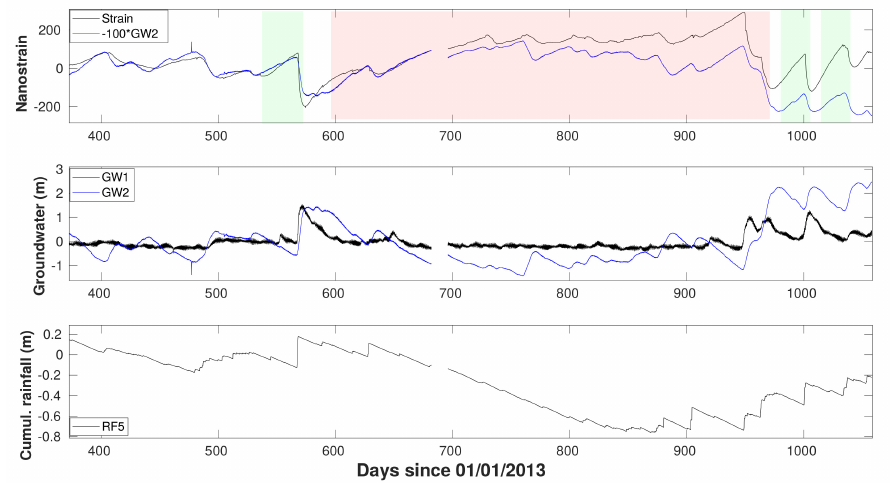
Figure 19. Dilatational strain (expansion > 0), groundwater level changes and detrended cumulative rainfall recorded in the Hualien-Taroko region by station SJNB (see Figure 2 for station locations). From top to bottom: dilatation (black curve) and groundwater level (station GW2, signal is inverted and multiplied by an arbitrary factor for comparison); groundwater level and detrended cumulative rainfall. Red and green shaded boxes show crustal strain modulation by groundwater level variations at an annual and bimonthly period,